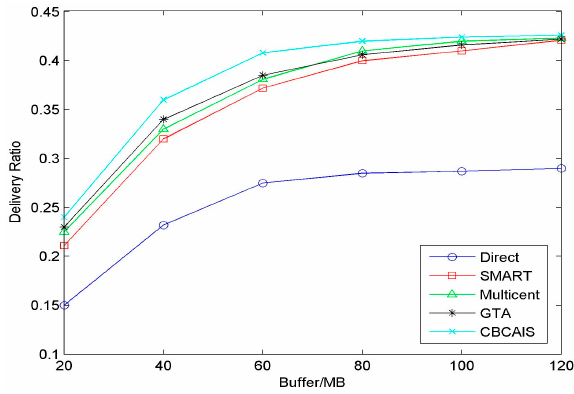
Figure 9. Delivery ratio for varying buffer size.